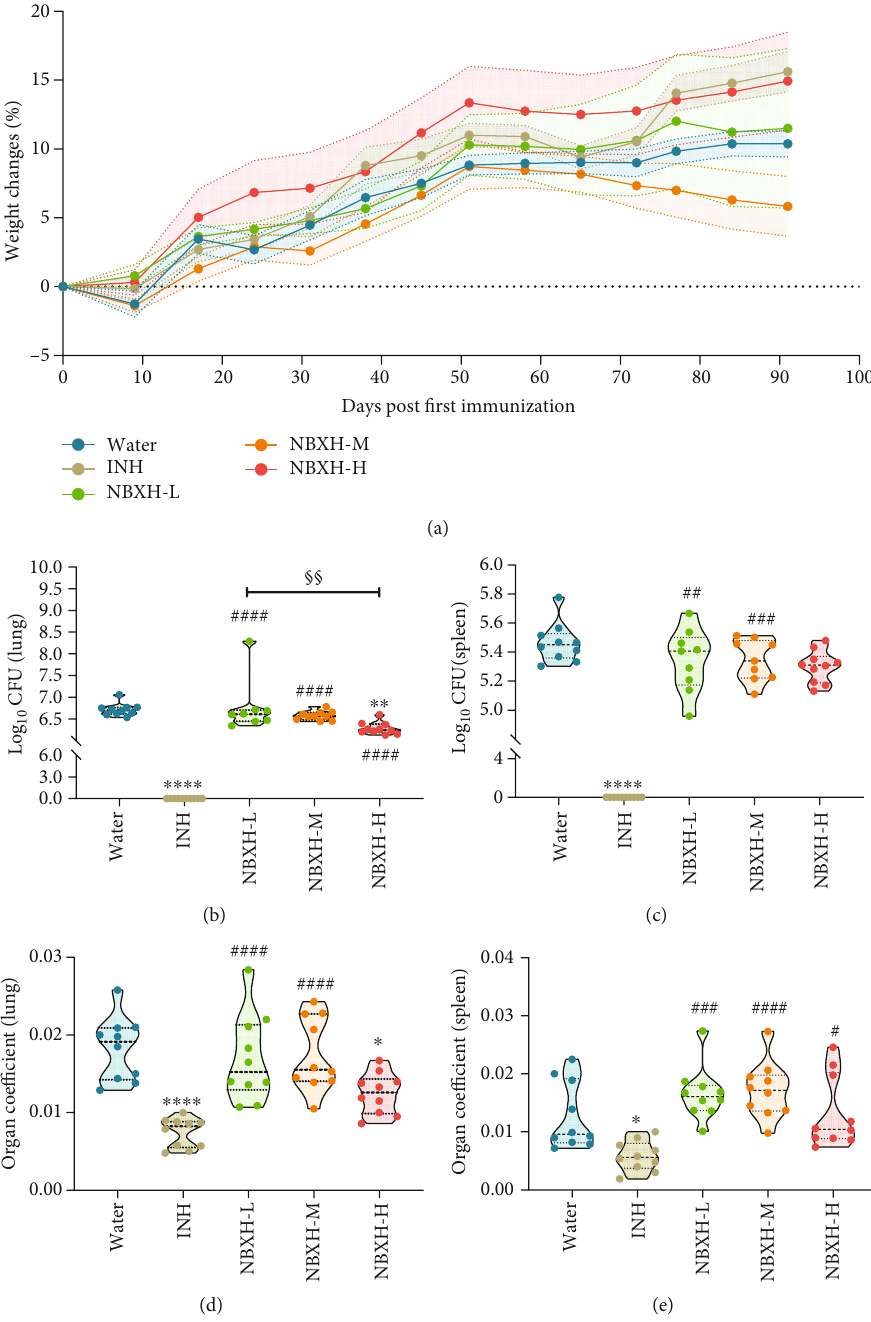
Figure 2: Immunotherapeutic e ffi cacy of NBXH extracts. The original weight of each mouse was obtained on day 0. After the fi rst immunotherapy, the weight change of each mouse was measured weekly (in (a), the error bar is represented by dotted lines). Ninety-one days after initial immunotherapy, all the mice were killed, and their left lobe of the lung (b) or spleen (b) was collected for counting CFUs, and organ coe ffi cient of the lung (d) or spleen (e) was performed. All data are shown as means ± S : E : M : ( n = 10 ). Di ff erences were considered statistically signi fi cant at P < 0 : 05 . ∗ vs. Water: ∗ P < 0 : 05 ; ∗∗ P < 0 : 01 ; ∗∗∗ P < 0 : 001 ; ∗∗∗∗ P < 0 : 0001 ; # vs. INH: # P < 0 : 05 ; ## P < 0 : 01 ; ### P < 0 : 001 ; #### P < 0 : 0001 ; § vs. NBXH-H: §§ P < 0 : 01